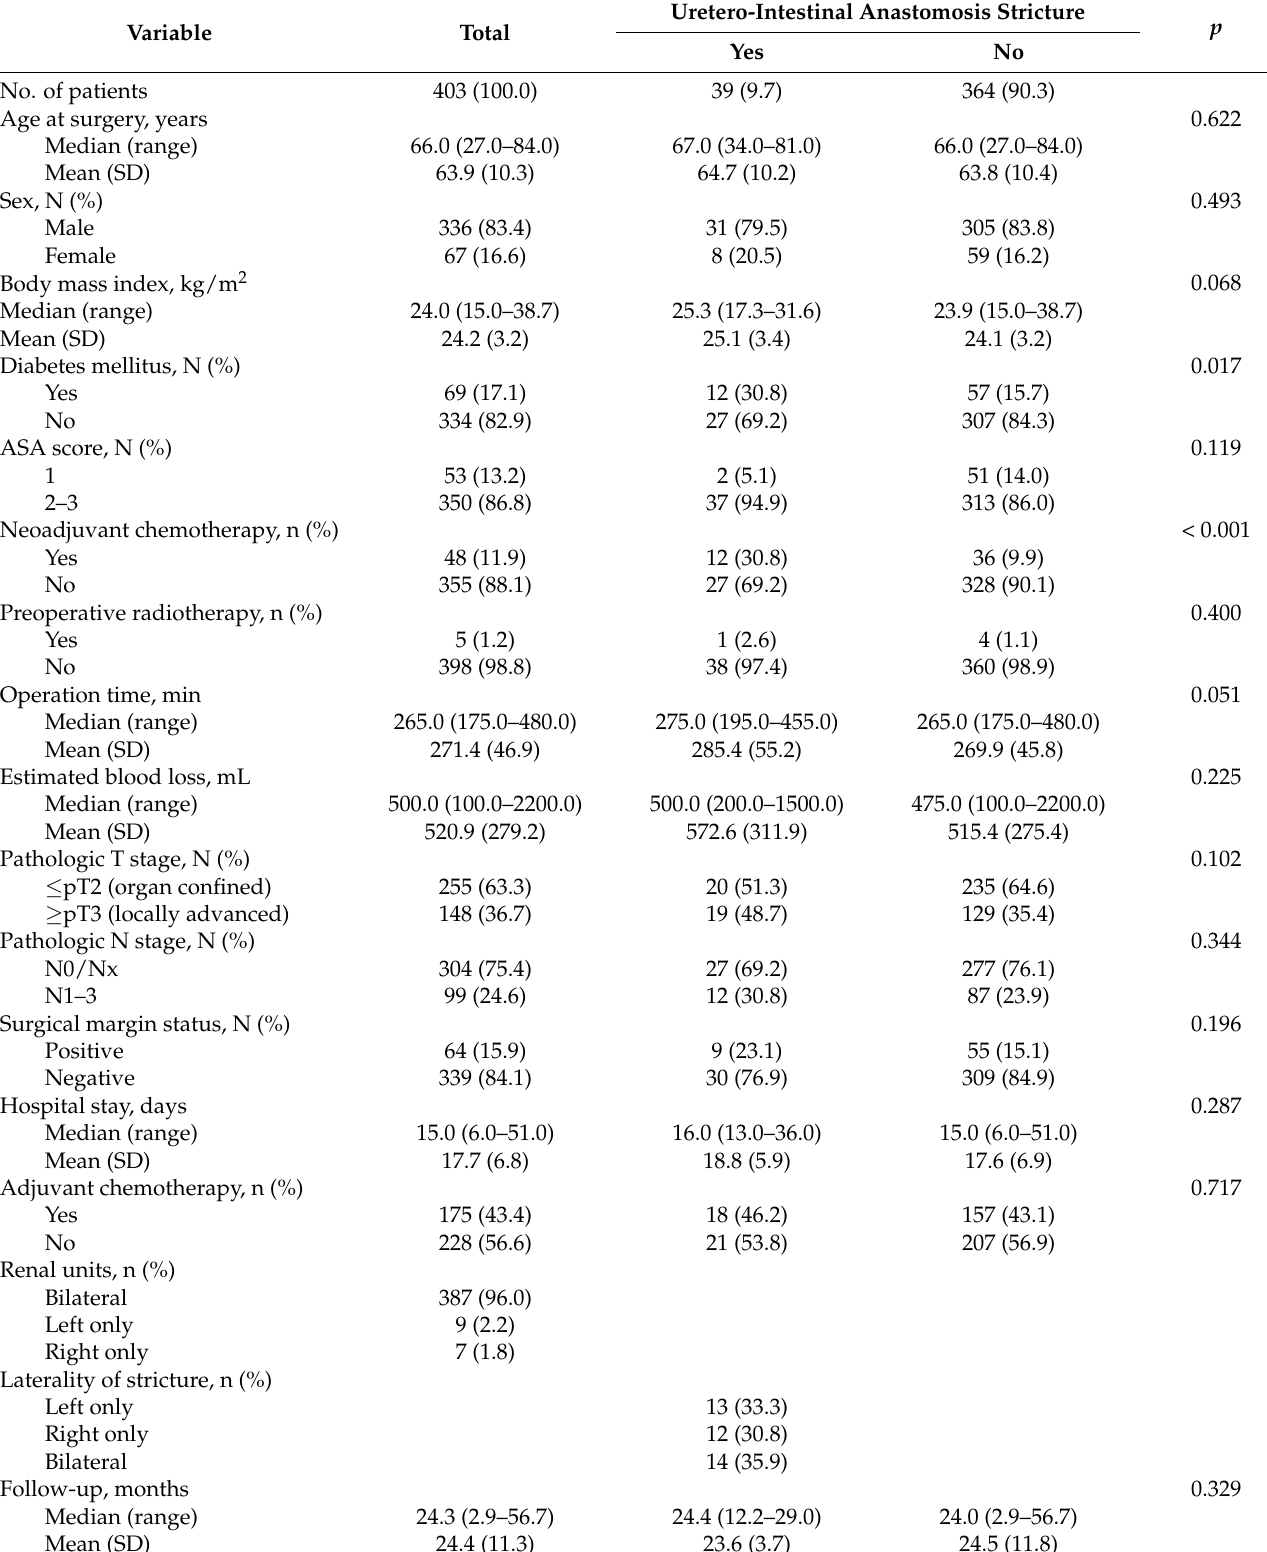
Table 1. Baseline characteristics of 403 patients who underwent radical cystectomy with ileal orthotopic